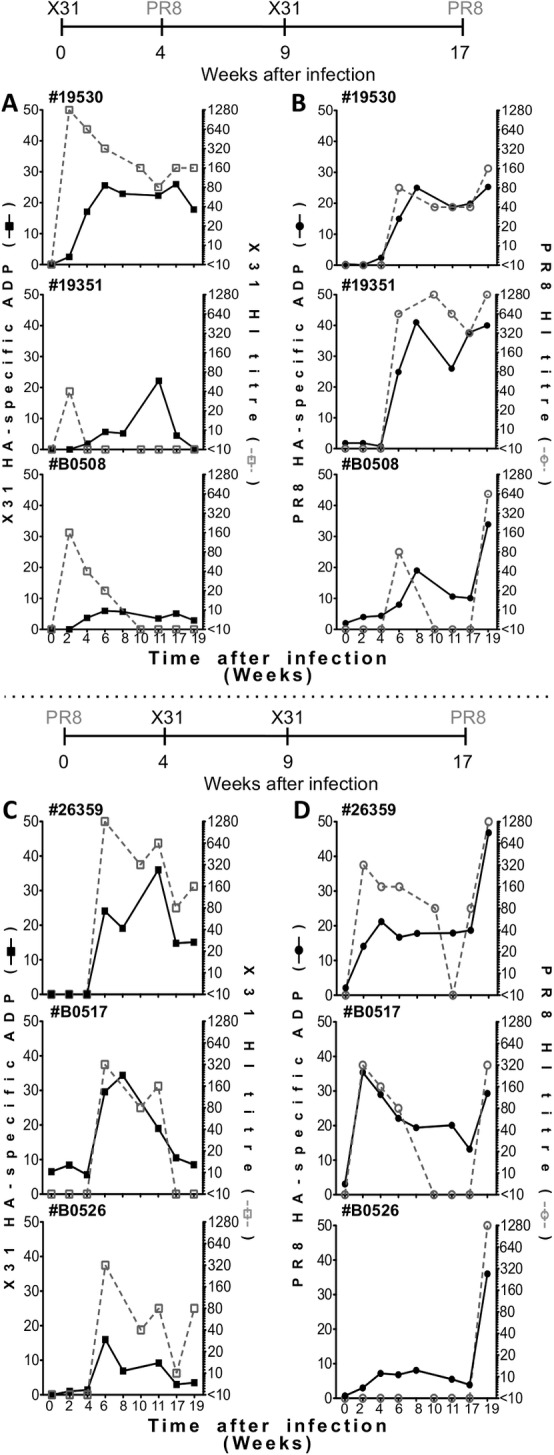
ADP in pigtail macaques infected with IAVs.HI titres (grey open symbol; dotted line) and ADP activity (black filled symbol; solid line) of 6 pigtail macaques infected twice with X31 (H3N2 A/HKx31) and PR8 (H1N1 A/Puerto Rico/08/1939). Grey arrows indicate influenza strain and time of infection which is summarized above the panels–the macaques in the top panels (A, B) were first infected with X31 and macaques in the bottom panels were first infected with PR8 (C, D). X31 and PR8 immune responses for each macaque are illustrated on A, C and B, D respectively. All ADP responses were corrected subtracting influenza-naïve macaque (mean of 3 animals) background.